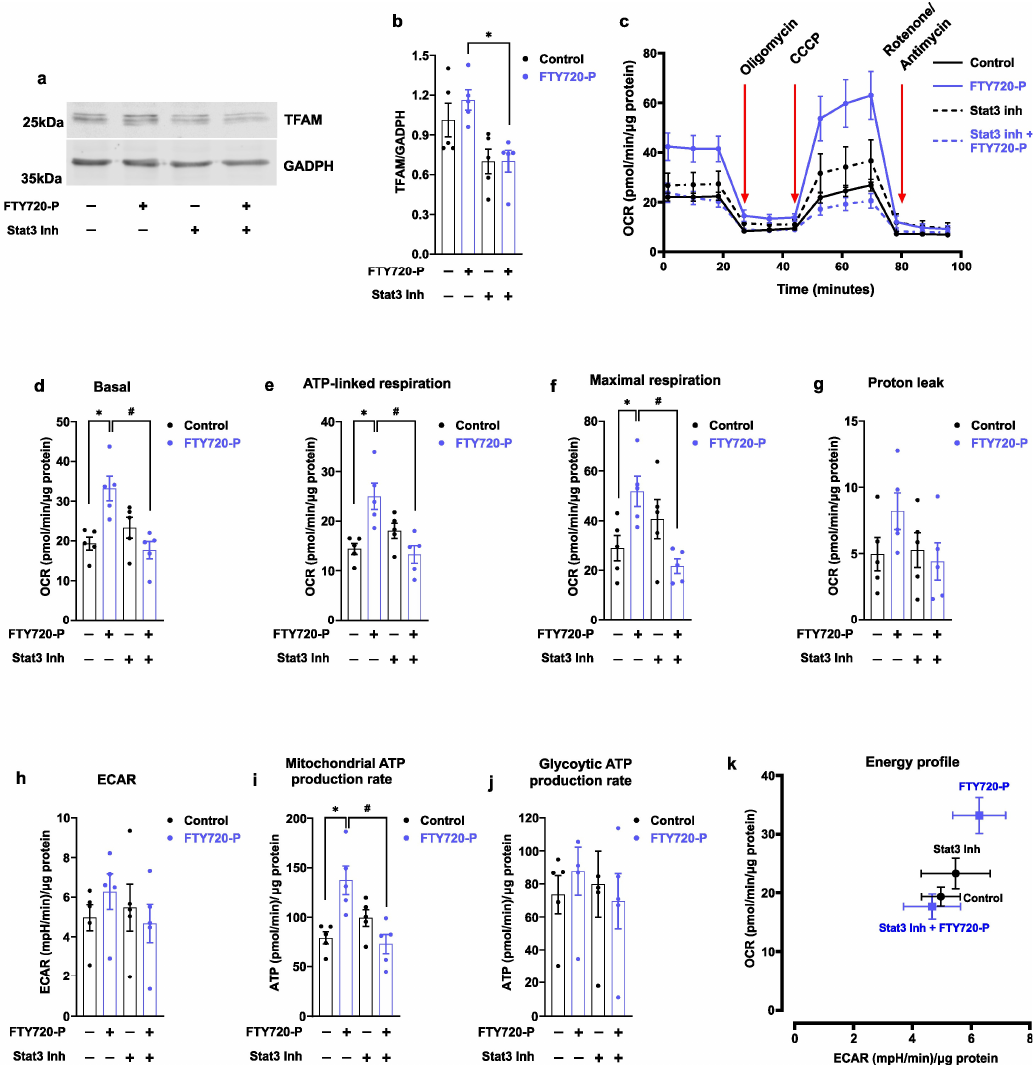
Figure 6. STAT3 inhibitor decreases FTY720-P-dependent mitochondrial activity. AC16 cells were co-treated with 100 nM FTY720-P and/or 25 μ M STAT3 inhibitor S3I-201 for 48 h. ( a ) STAT3 inhibitor decreases TFAM protein expression. TFAM was detected in total protein extracts using Western blot. GADPH was used as a loading control. Densitometric quantification is shown in ( b ). Data were subjected to unpaired t -test. Data are mean ± SEM. * p -value < 0.05 vs. FT720-P-treated cells. Graphs represent 5 independent experiments. ( c – k ) Mitochondrial respiration was performed using Seahorse real-time, life cell respirometry. ( c ) Representative oxygen consumption rate (OCR) of AC16 cells co-treated with 100 nM FTY720-P and/or 25 μ M STAT3 inhibitor S3I-201 for 48 h. ( d ) Basal, ( e ) ATP-linked respiration, ( f ) maximal respiration, ( g ) mitochondrial leak, and ( h ) extracellular acidification rate (ECAR) were analyzed using Seahorse respirometry. ( i ) Mitochondrial and ( j ) glycolytic ATP calculated using OCR and ECAR data obtained by Seahorse respirometry. ( k ) Energy profile of AC16 cells determined as a basal OCR as a function of basal ECAR in the indicated conditions. Data were subjected to one-way ANOVA. Data are mean ± SEM. * p -value < 0.05 vs. control cells; # p -value < 0.05 vs. FT720-P-treated cells. Graphs represent 5 independent experiments performed in